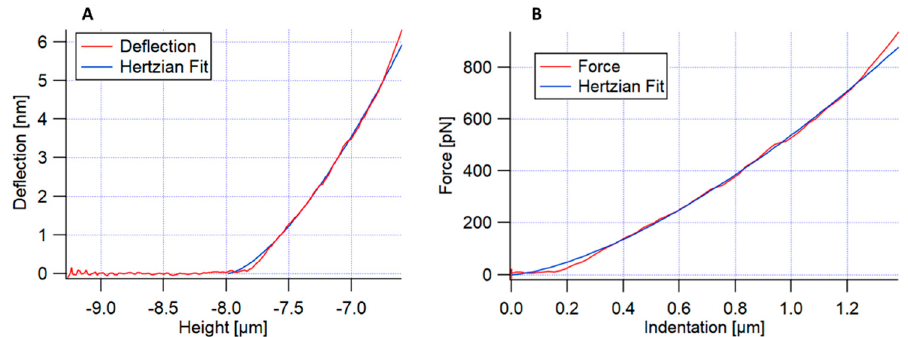
Figure 1. Representation of an example of the approach of a conventional force–distance curve. ( A ) Approach curve (cantilever deflection versus the height piezo), with Hertz’s fitting; ( B ) Hertz’s fitting of the force versus indentation of the sample.